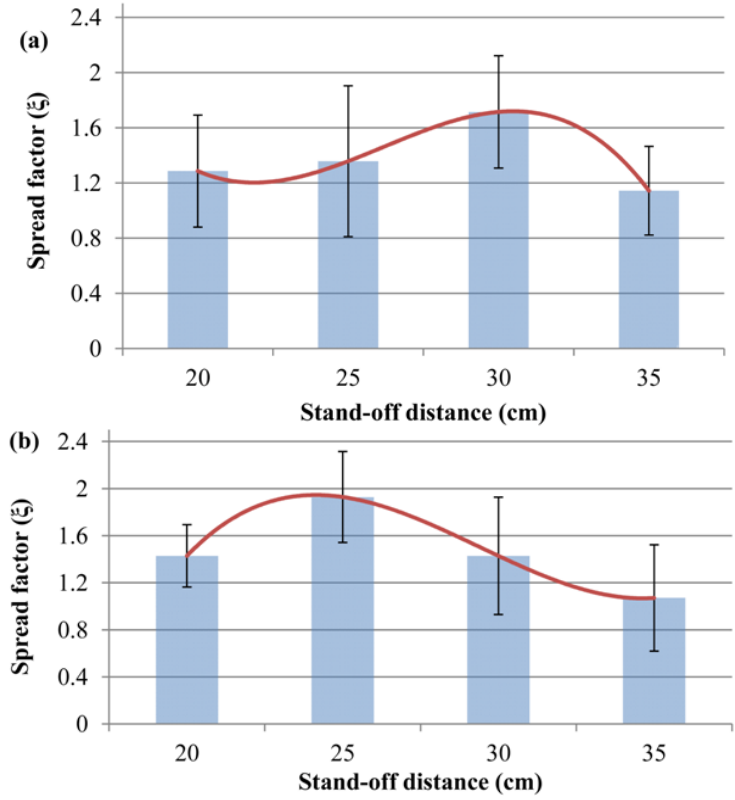
Figure 4. The effect of stand-off distance on the spread factor of EMAA single splats on ( a ) Glass and ( b ) Mild steel